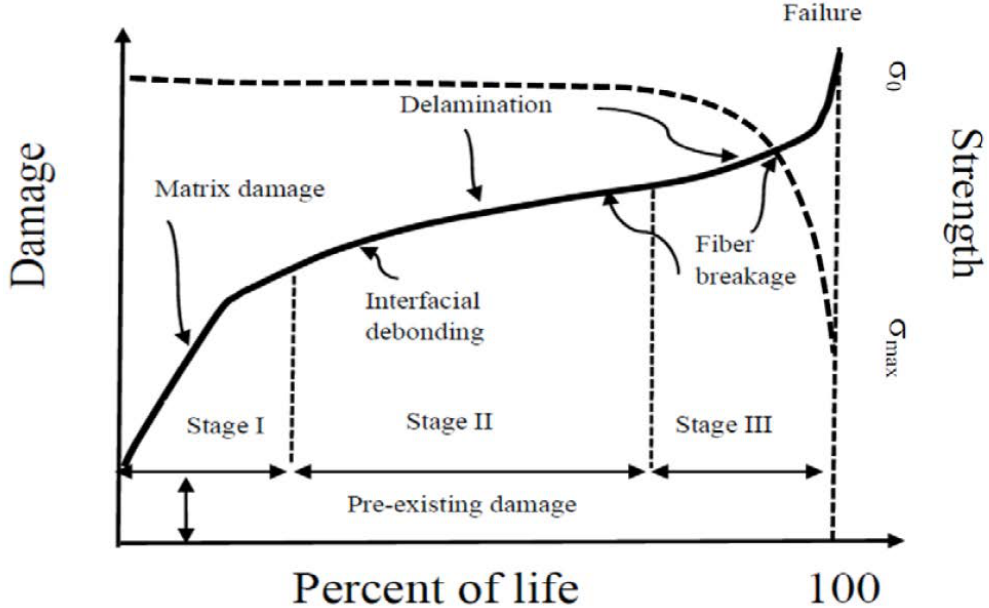
Figure 6. The schematic of damage development and the corresponding strength evolution under constant amplitude (CA) loadings.